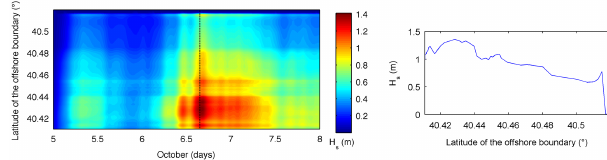
Figure 8. Color map of the significant wave height, H s , imposed on the offshore boundary of the 3-D model in time (left panel) and prescribed signal variation on the boundary outline extracted for an exemplary instance (right panel): instance of 6 October 2014 14:00 noted as a dotted line in the left